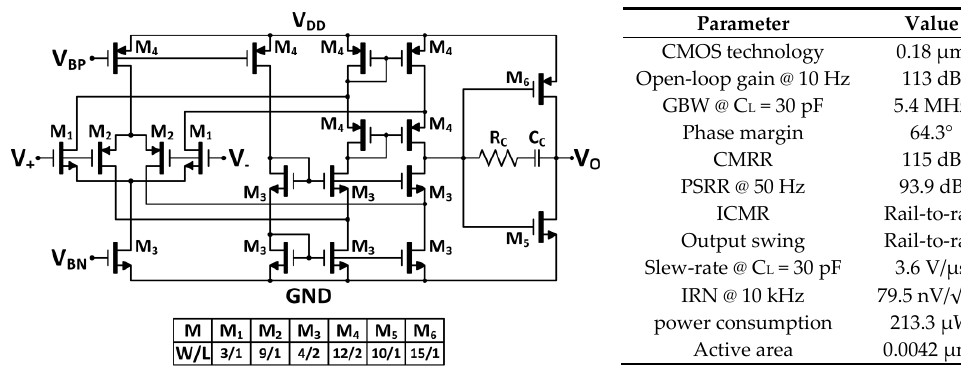
Figure 3. Operational amplifier schematic topology with transistor sizes in µm, and main post-layout simulated performances.